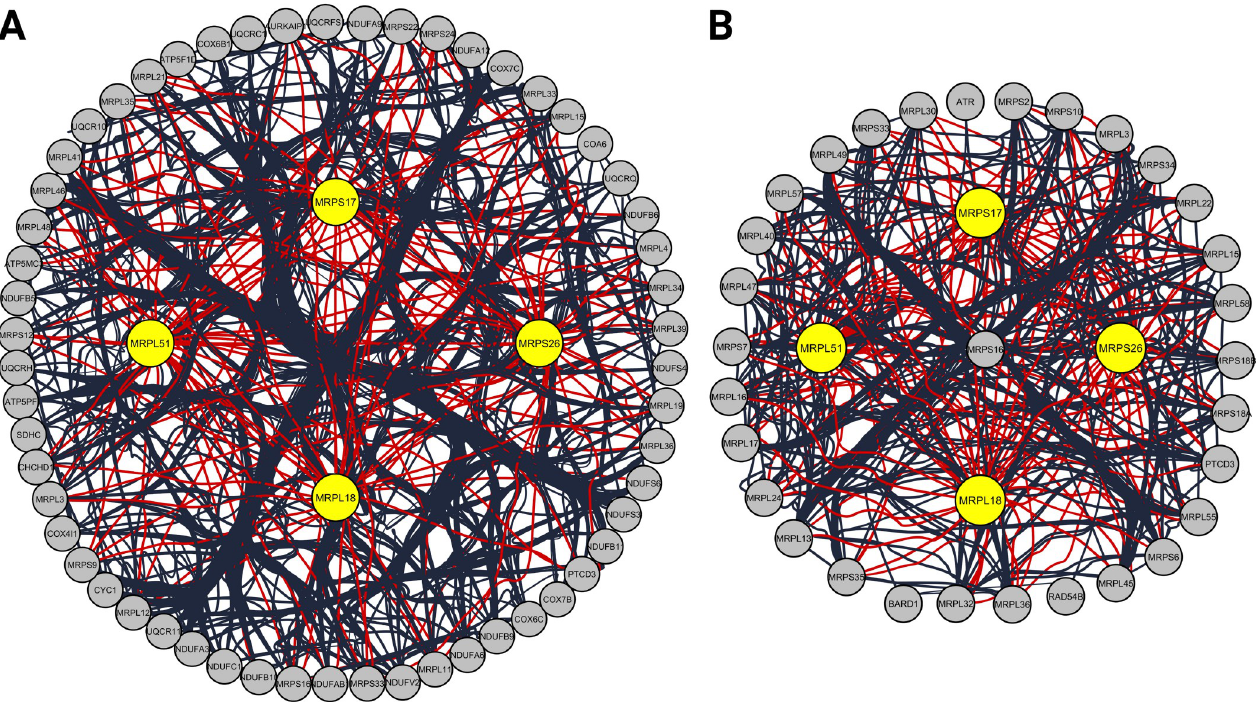
Fig 2. Hub genes of clustering modules in the protein-protein interaction network of differentially expressed genes from (A) musculoskeletal ageing and (B) non-small cell lung cancer (NSCLC) patients, that were linked with reduced overall survival, opposing tissue expression to musculoskeletal ageing and tumour purity in patients with NSCLC from public transcriptome data. Yellow nodes constitute hub genes. MRPL18: Mitochondrial Ribosomal Protein L18; MRPL51: Mitochondrial Ribosomal Protein L51; MRPS17: Mitochondrial Ribosomal Protein S17; MRPS26: Mitochondrial Ribosomal Protein S26.